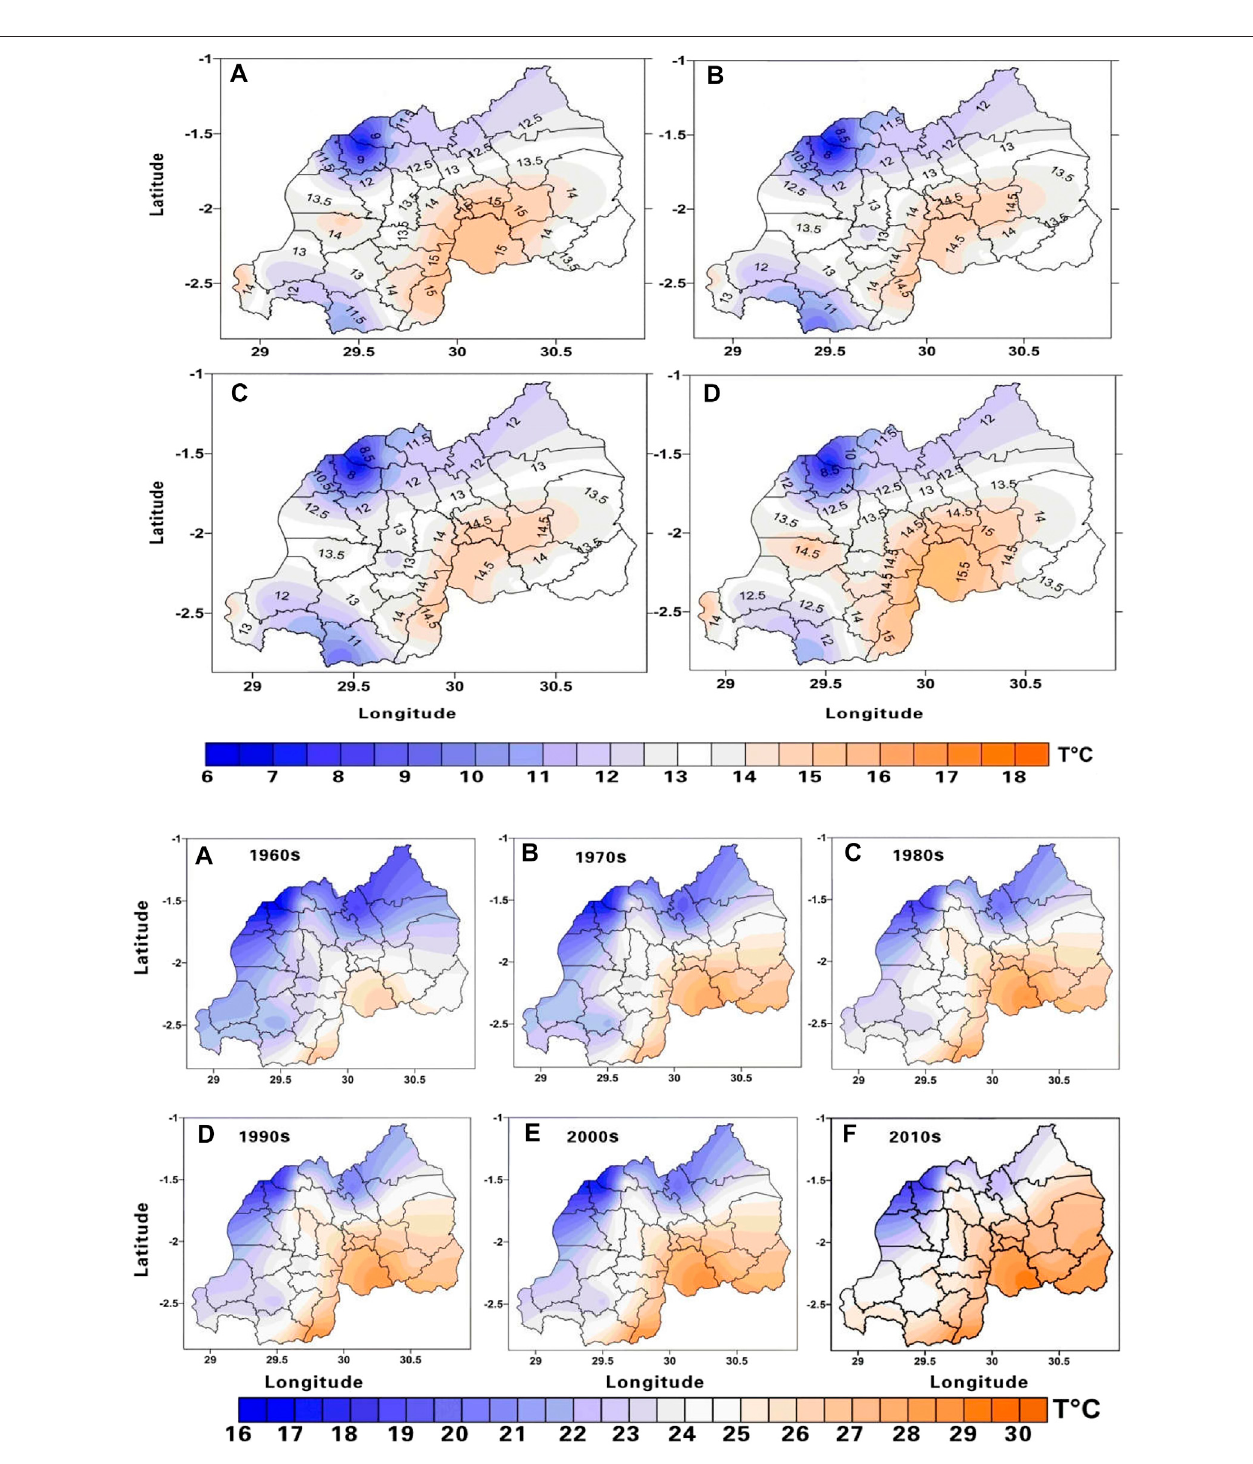
FIGURE 4b | The same analysis for